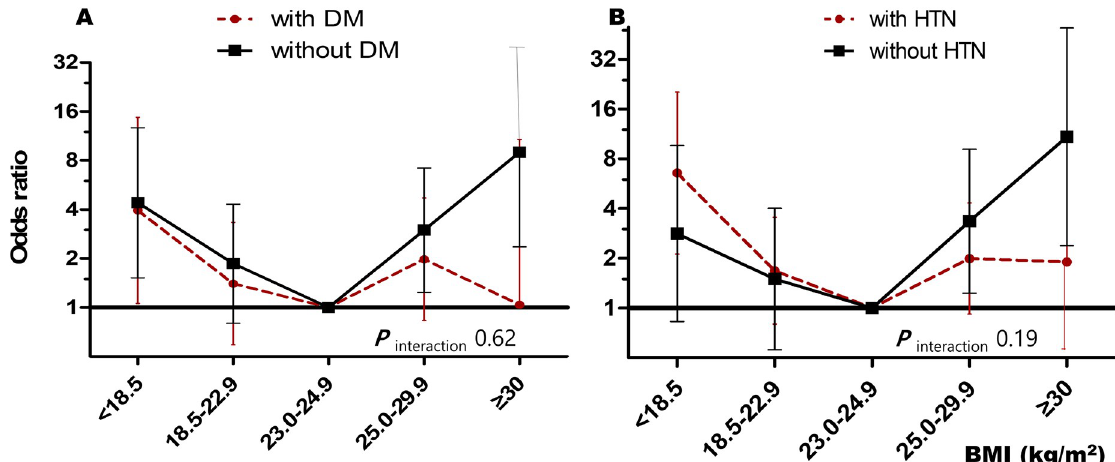
Fig 3. Subgroup analyses for fatal illness according to the BMI in patients with/without diabetes mellitus or hypertension (A) Diabetes Mellitus � , (B) Hypertension �� . � Odds ratios were adjusted for age, gender, and four comorbidities (hypertension, chronic kidney disease, cancer, and dementia). �� Odds ratios were adjusted for age, gender, and four comorbidities (diabetes mellitus, chronic kidney disease, cancer, and